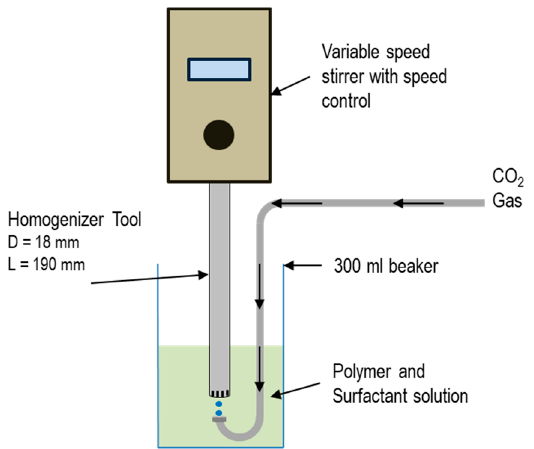
Figure 2. Schematic of CO 2 microbubbles generator setup.